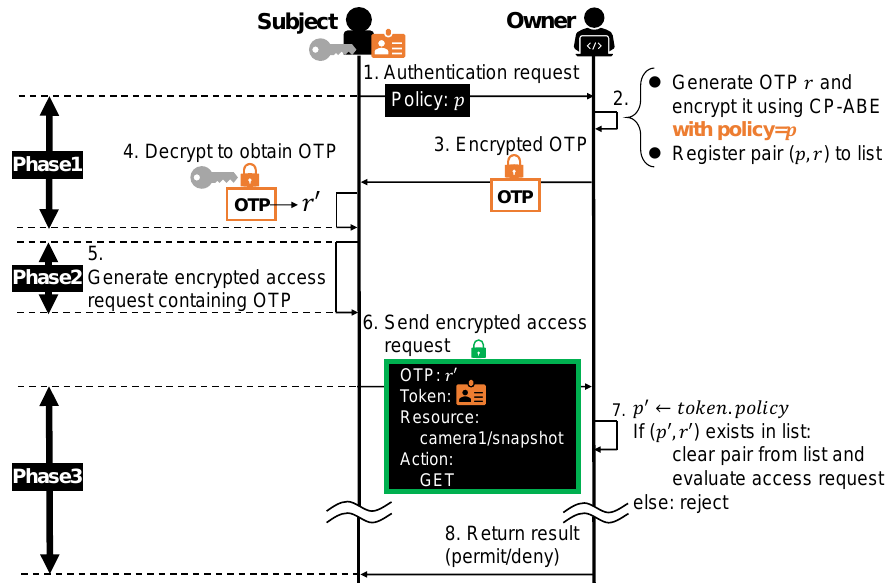
Figure 9. Proposed scheme: access right verification (authentication